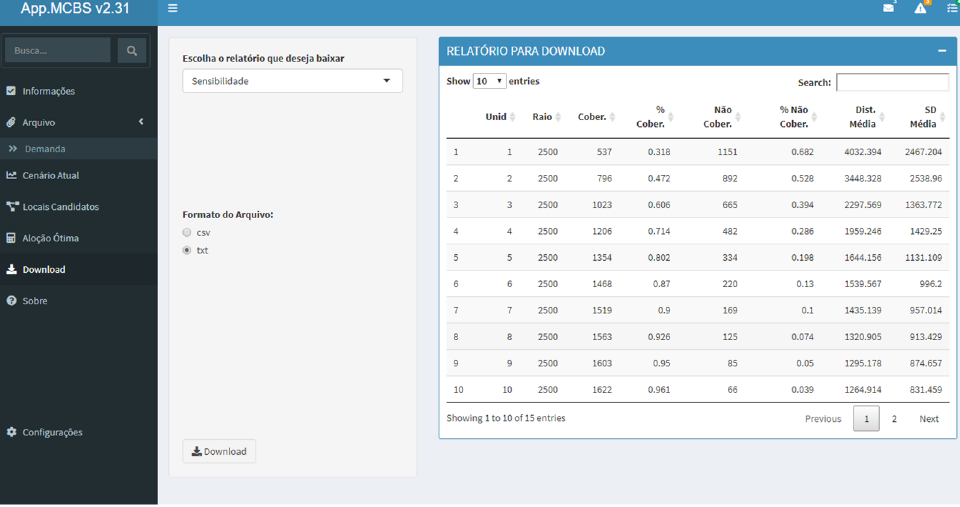
Figure 6. Preprint reports screen.